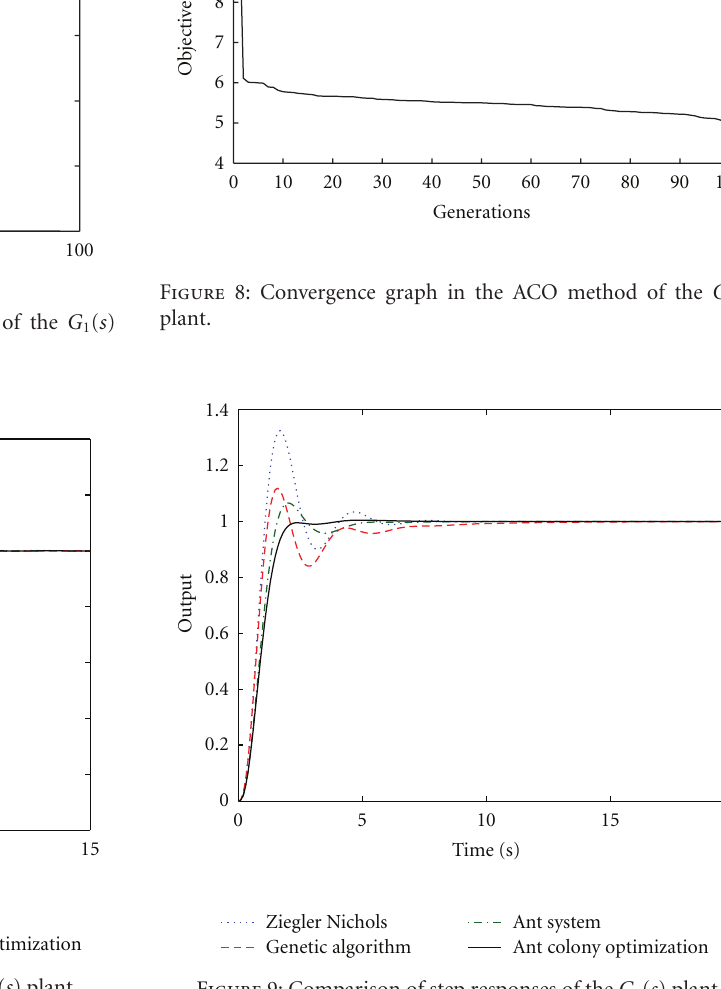
Figure 9: Comparison of step responses of the G 3 ( s ) plant.